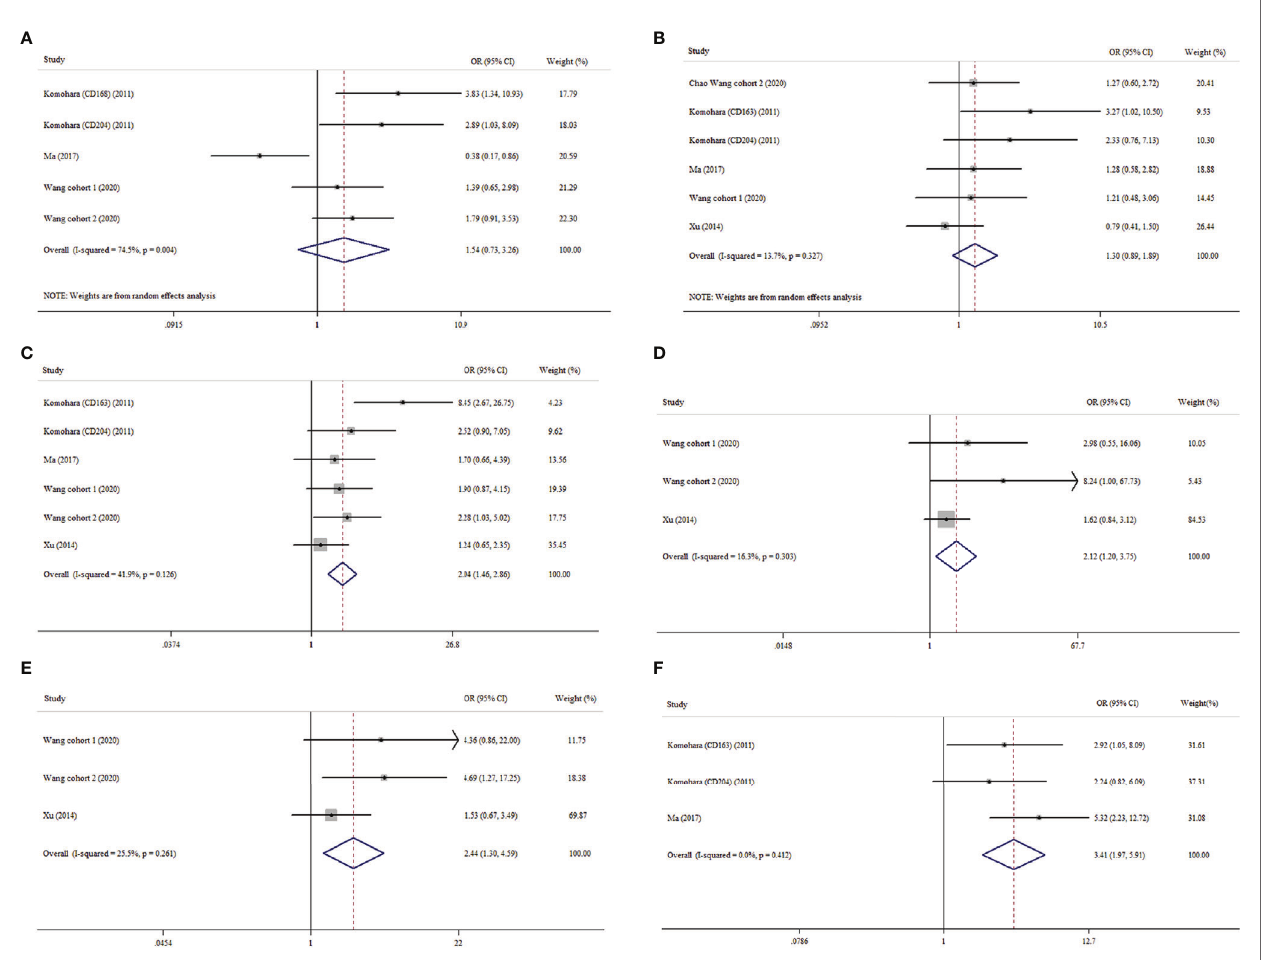
FIGURE 4 | Forest plots of ORs accessing the correlation between M2-TAMs density and clinicopathological features. (A) M2-TAMs and age; (B) M2-TAMs and gender; (C) M2-TAMs and nuclear grade; (D) M2-TAMs TAMs and tumor necrosis; (E) M2-TAMs TAMs and UICC-stage; (F) M2-TAMs TAMs and tumor